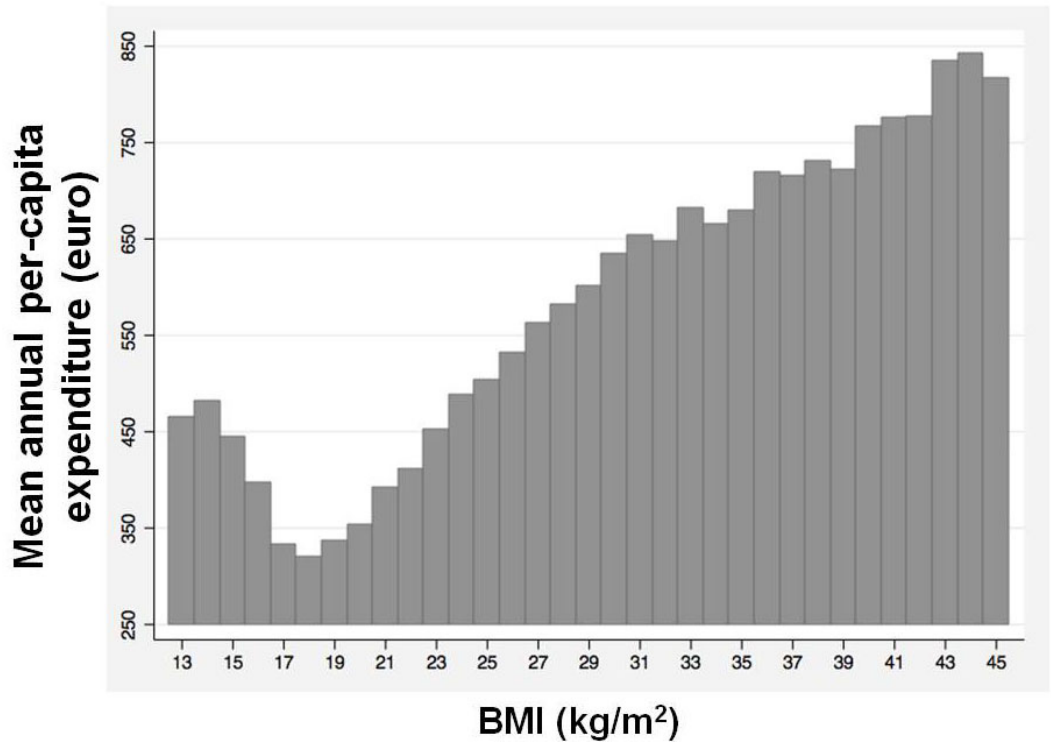
Figure 1. Average annual per capita health care cost by body mass index (BMI) categories. Age-adjusted outpatient health care costs (e.g. pharmaceutical, diagnostic and specialist visit expenditure) are shown per capita per year. We examined the relationship between BMI and medical care expenditure based on a sample of 423,682 Italian adults aged 18–95 in 2008–2010 (unpublished